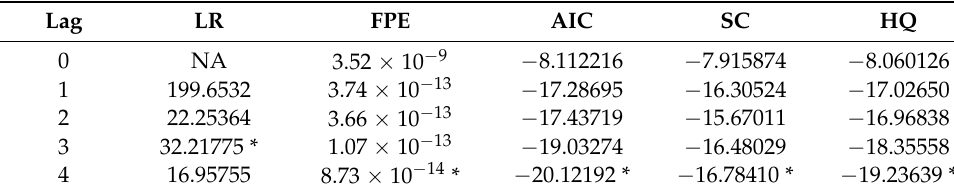
Table 4. VAR model test results for each lag order.